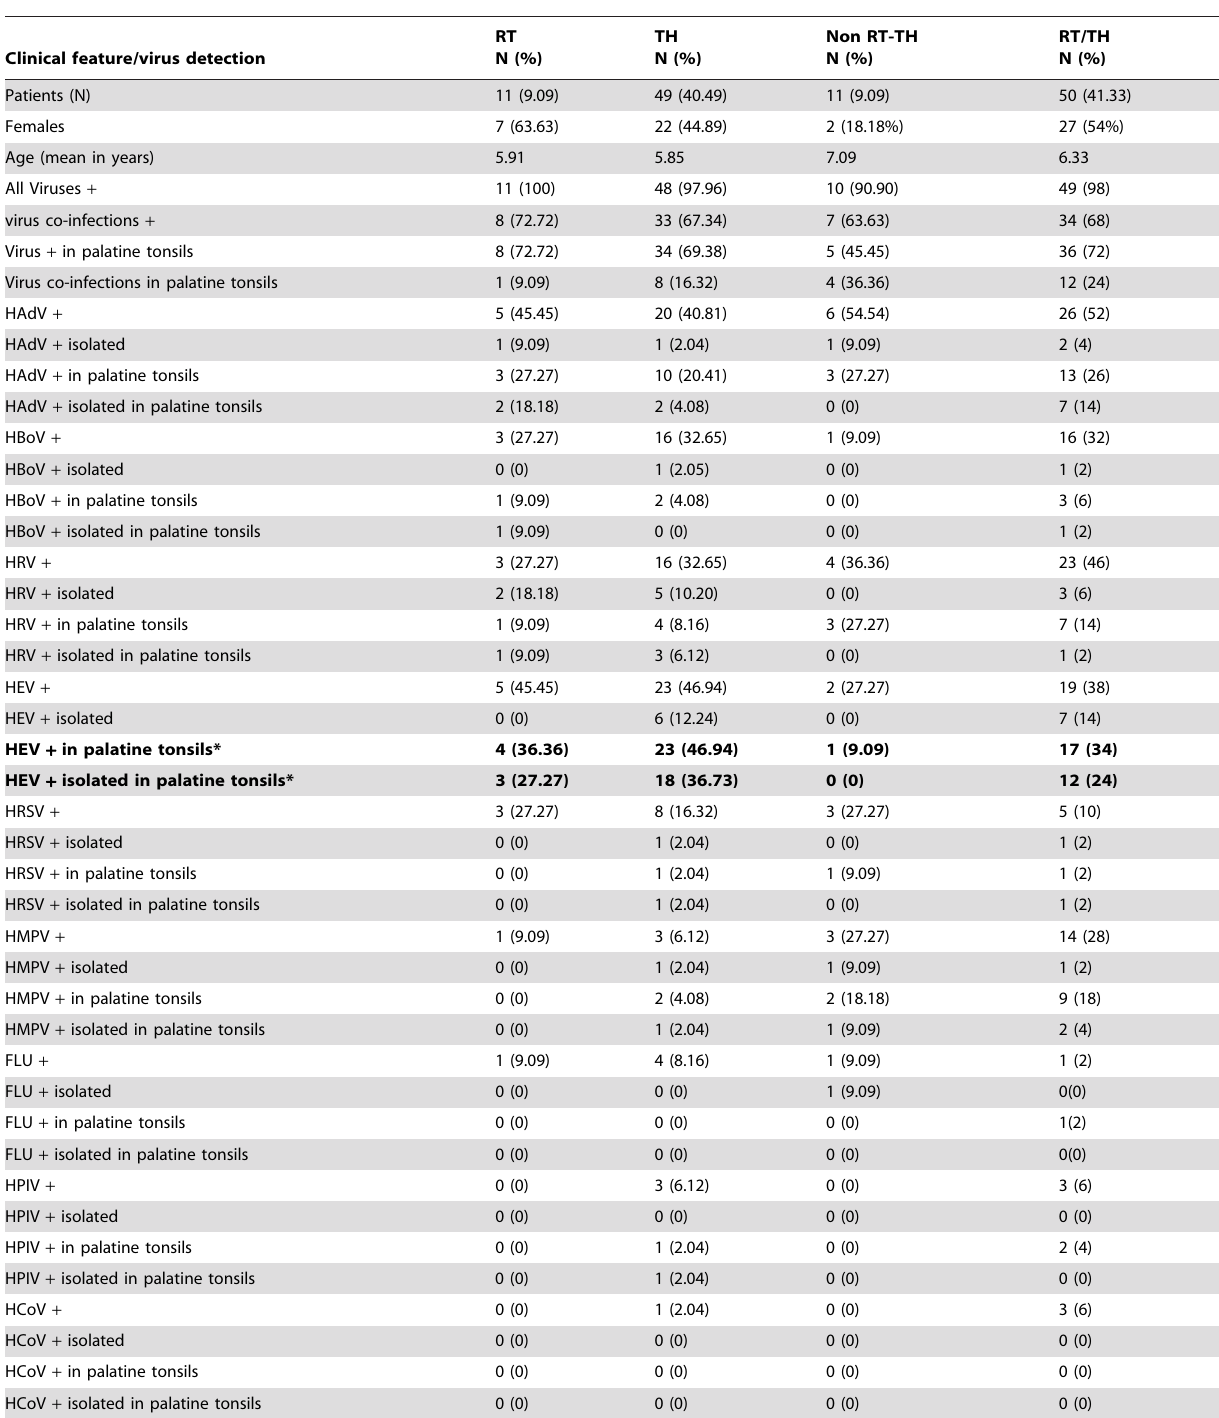
Table 4. Demographic data and virus detection frequencies in patients according to categories of adenotonsillar disease.